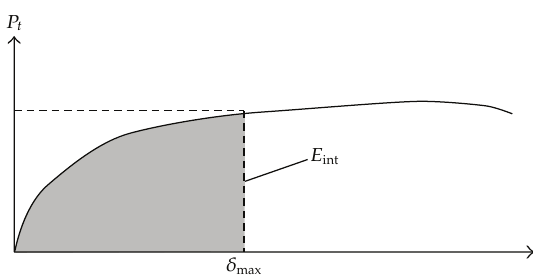
Figure 7: Evolution of the resistance of the gate with the penetration of the